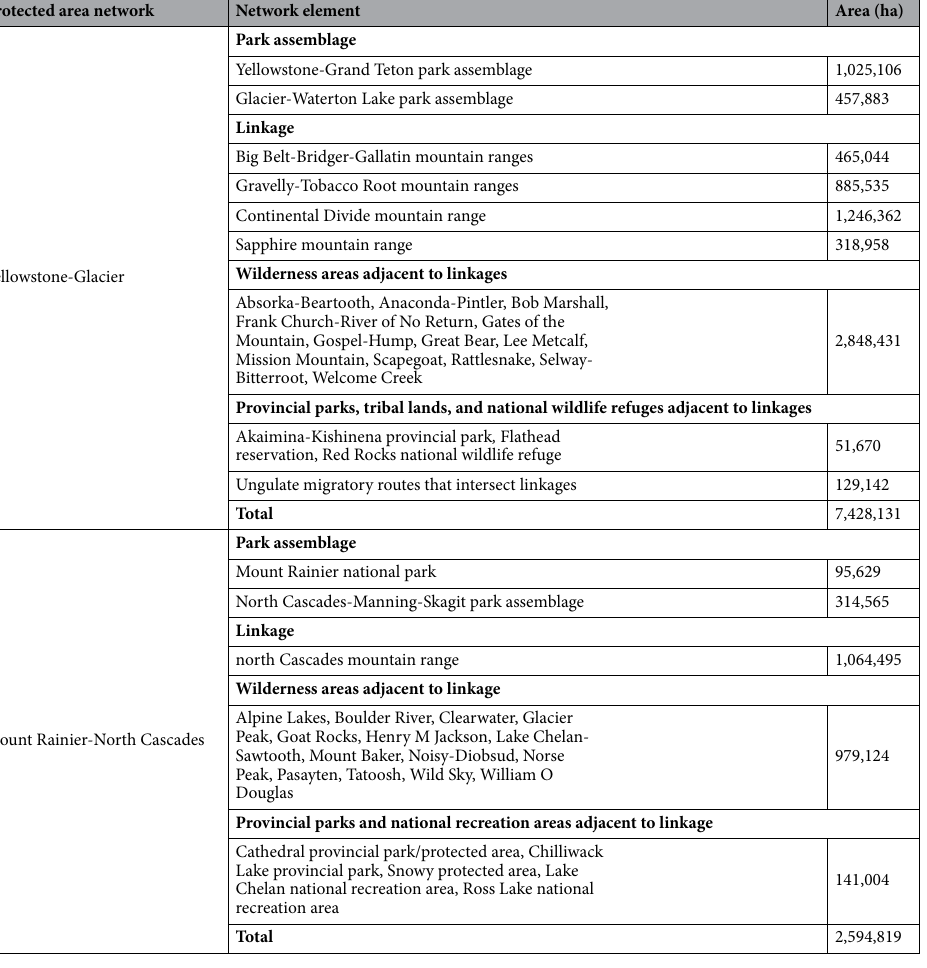
Table 1. Summary by area of park assemblages, linkages, and wilderness areas and seasonal migratory routes that intersect linkages in the Yellowstone-Glacier and Mount Rainier-North Cascades protected area